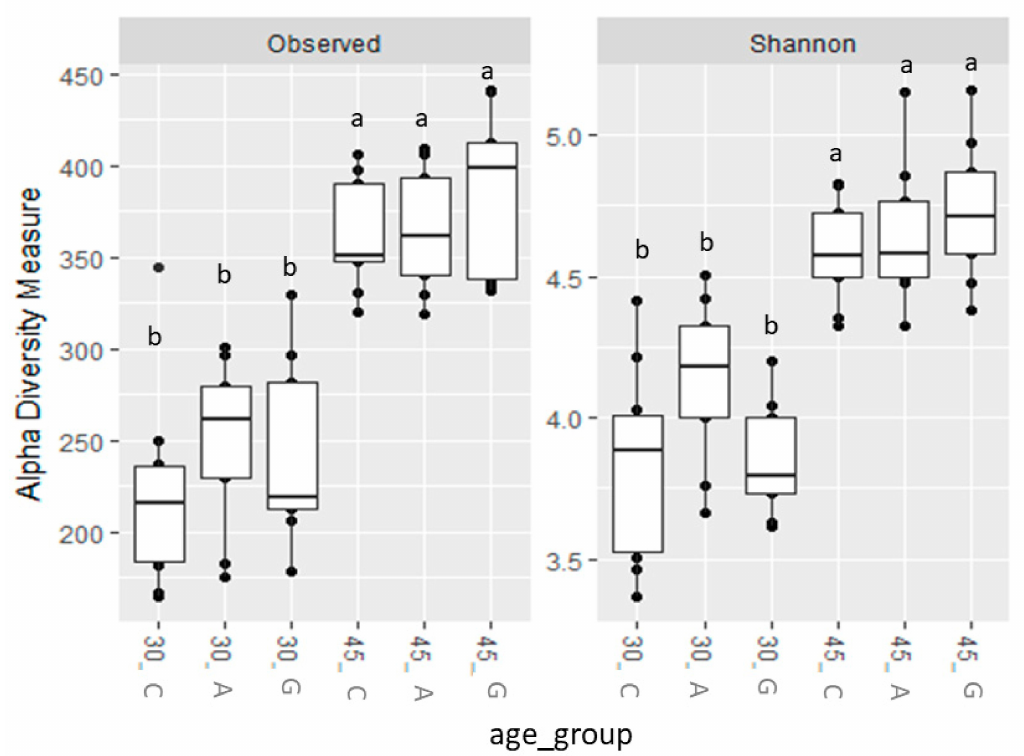
Figure A1. E ff ect of dietary supplementation with dehydrated alfalfa or fresh grass in peri-weaning period on alpha-diversity rabbit caecal microbiota: ( left ) observed means species richness; ( right ) Shannon diversity. C = rabbit fed pelleted feed only; A = rabbit fed pelleted feed + dehydrated alfalfa; G = rabbit fed pelleted feed + fresh grass. a,b Values within a row with di ff erent superscript letters di ff er significantly at p <